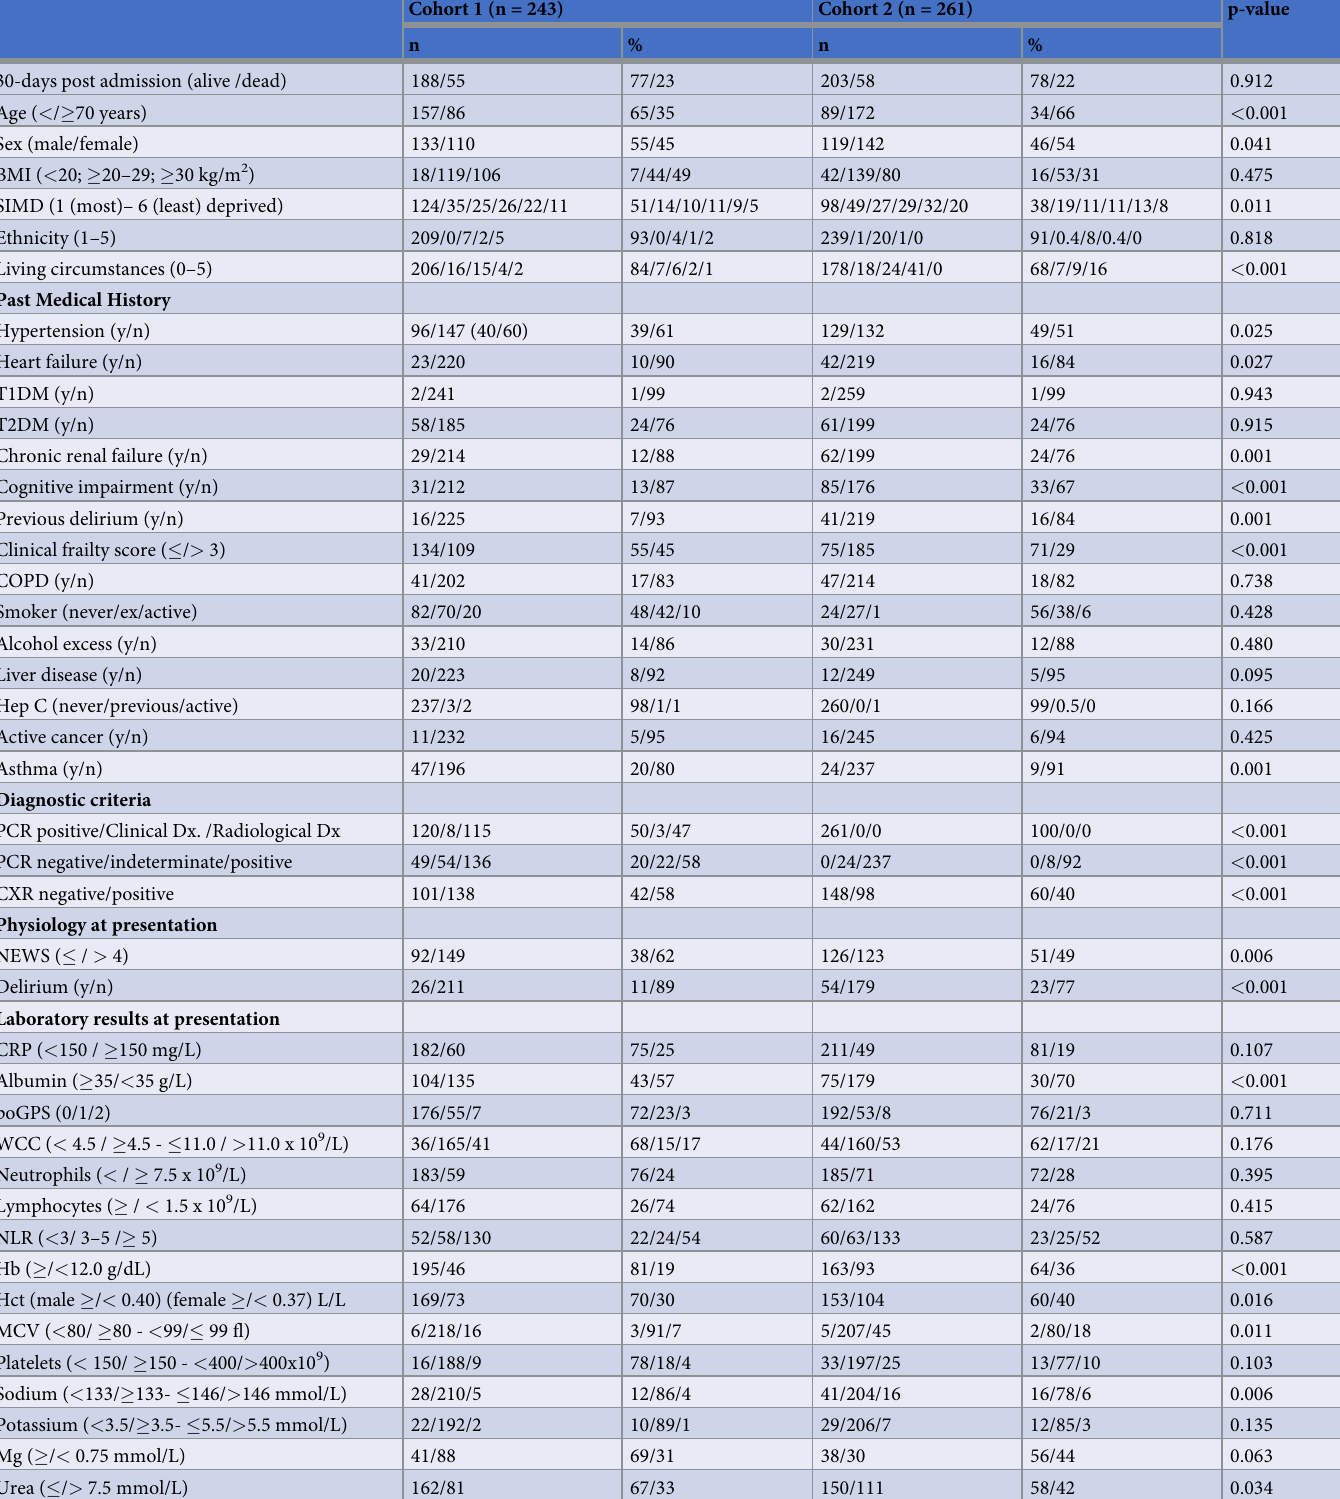
Table 4. Comparison of the demographical and clinicopathological characteristics of 2 consecutive cohorts patients admitted to hospital with